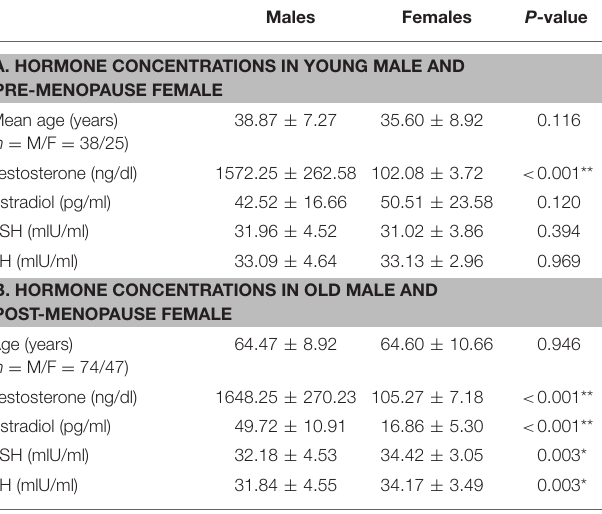
TABLE 2 | Sex hormone concentrations of CRC